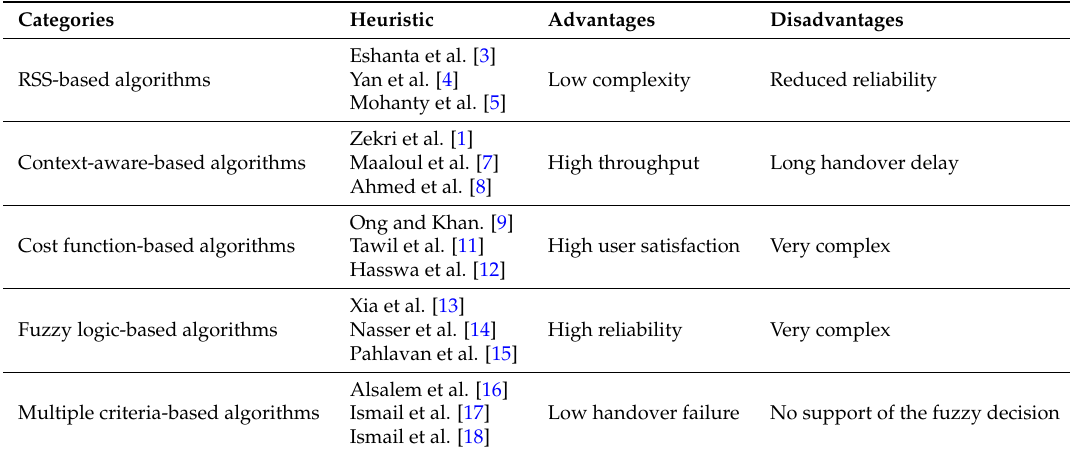
Table 1. A comparative summary of the vertical handover decision